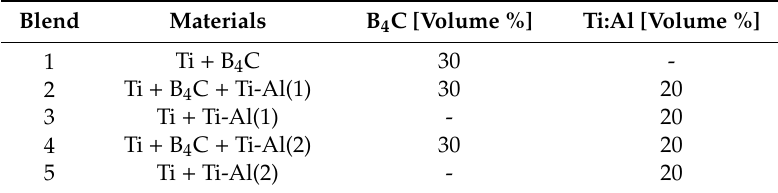
Table 1. Summary of the composition of the tested specimens.